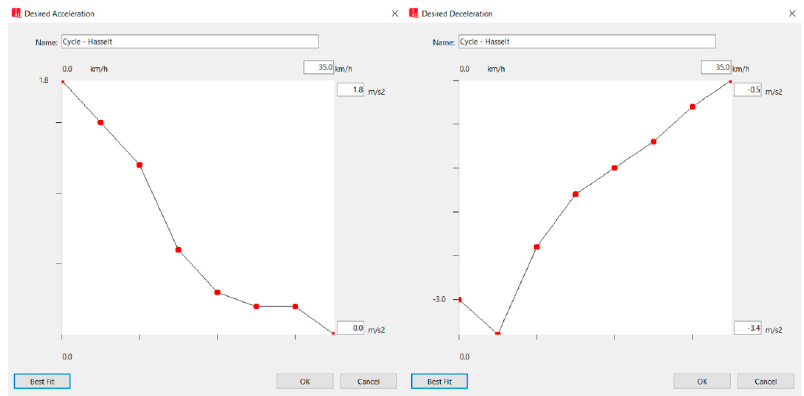
Figure 5. Implemented acceleration ( left )—deceleration ( right ) distributions for cyclists.